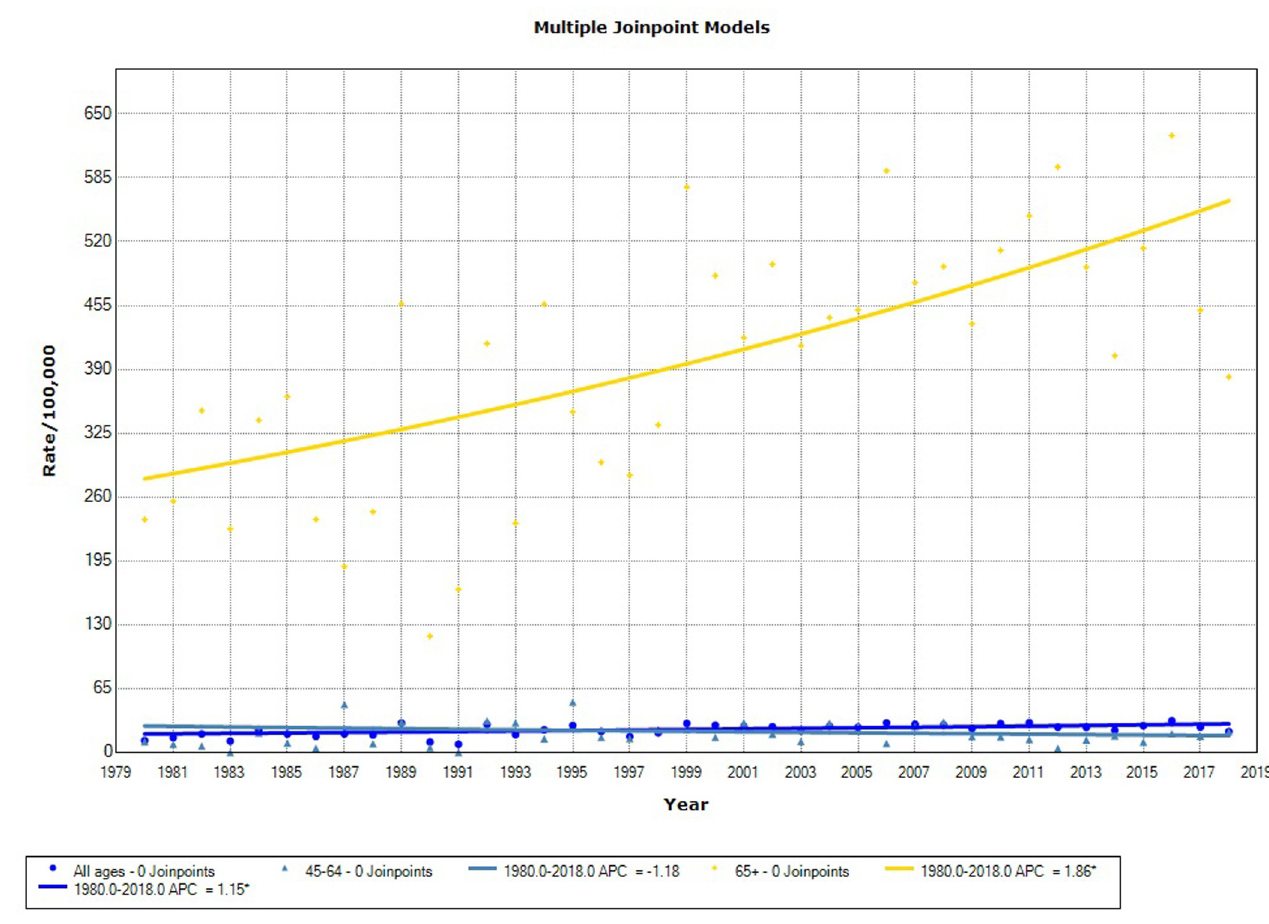
Fig 2. Mortality trends for prostate cancer in the cancer registry area,